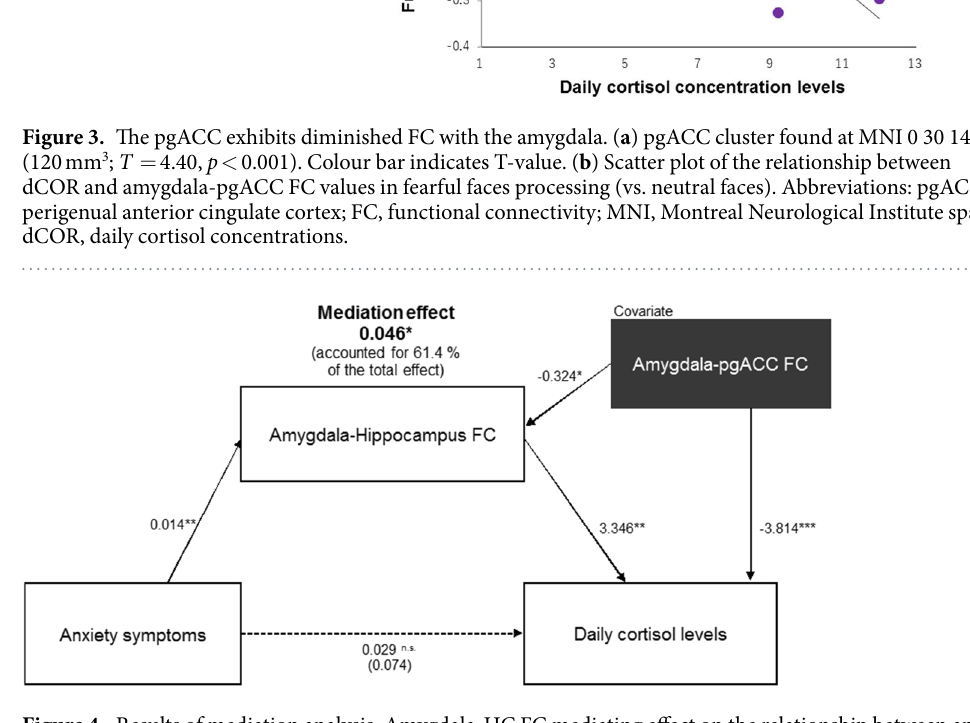
Figure 4. Results of mediation analysis. Amygdala-HC FC mediating effect on the relationship between anxiety symptoms and dCOR. The effect of the amygdala-pgACC FC was incorporated as covariate in the mediation model. Abbreviations: HC, hippocampus; FC, functional connectivity; dCOR, daily cortisol concentrations; pgACC, periginual anterior cingulate cortex. * p < 0.05, ** p < 0.01, *** p < 0.001. All path coefficients are unstandardized regression weights. The value in parentheses indicates anxiety symptoms’ total effect on